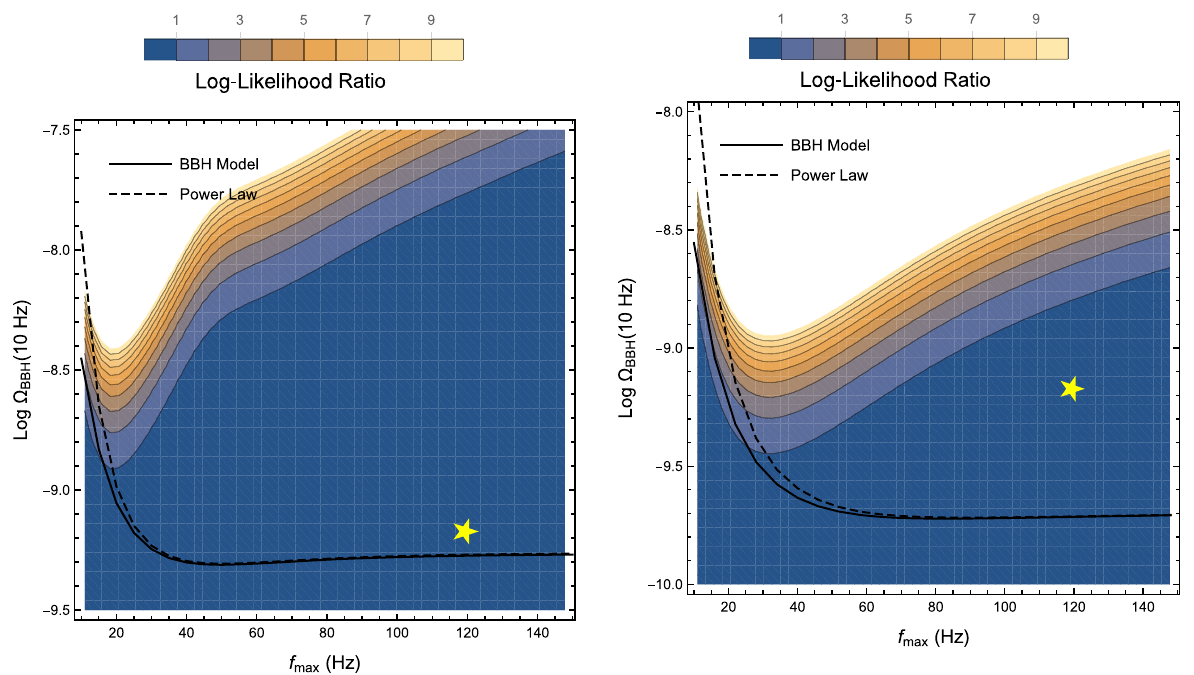
FIG. 4. Maximum log-likelihood contours between the astrophysical and power-law models, as a function f (see Fig. 1) and the max background ’ s amplitude at 10 Hz. Results are shown for Advanced LIGO (left) and a network of colocated aLIGO detectors (right), assuming three years of integration at design sensitivity. Advanced LIGO is best able to distinguish realistic background models from power laws for frequencies f between 10 and 50 Hz, corresponding to the most sensitive frequency band for the stochastic search. As max in Fig. 3, solid and dashed black curves show the amplitudes at which a background is detectable with SNR ¼ 3 after three years, using the Fiducial and power-law models, respectively. The star indicates the Fiducial background associated with